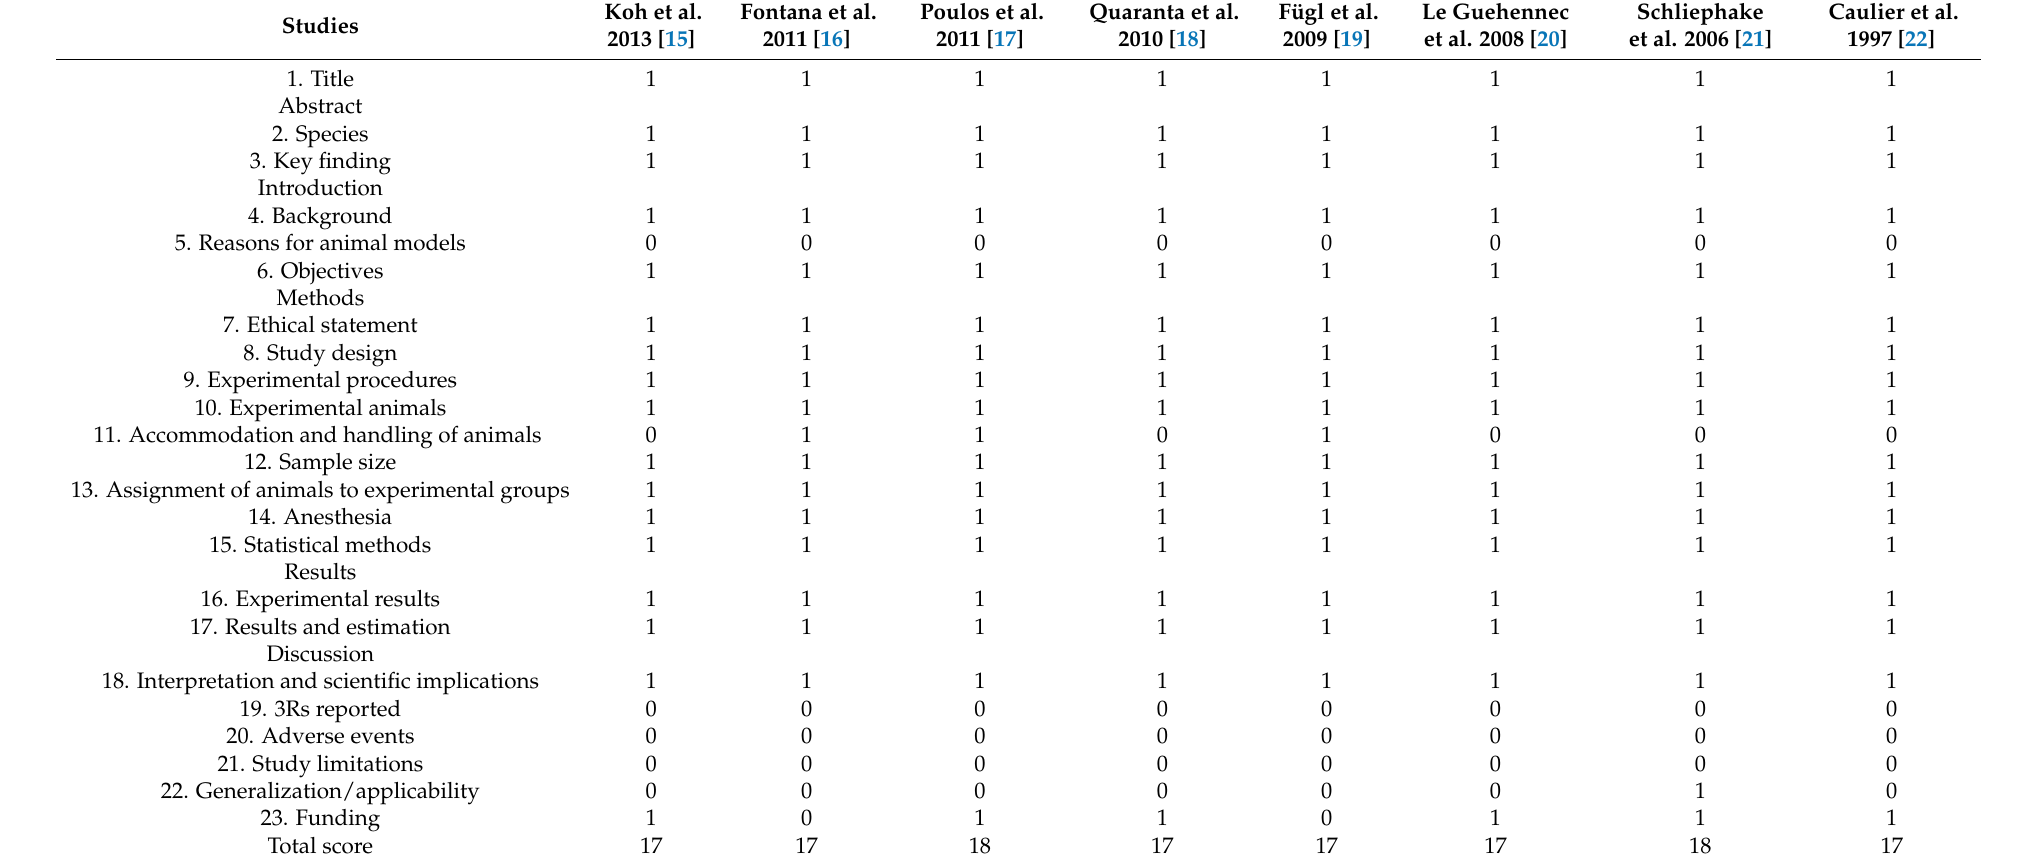
Table 2. Checklist of ARRIVE criteria reported by the included studies. Each item was judged as “0” (not reported) or “1” (reported). The total score of each of included studies was also